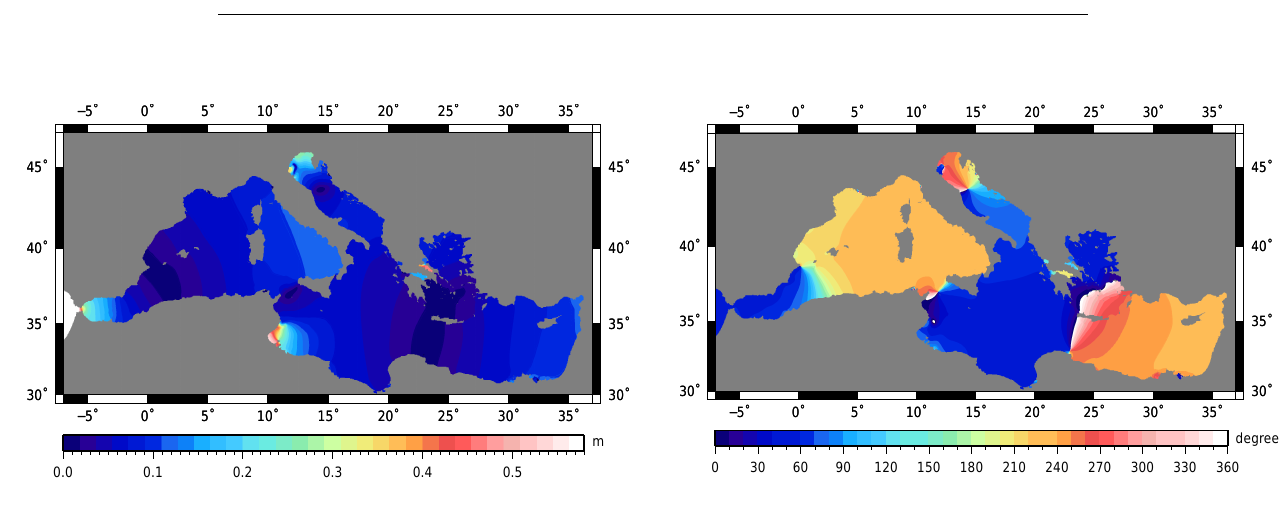
Fig.4. AmplitudeoftheM2constituent Fig. 4. Amplitude of the M2 constituent. the control data-set (ii). Taking into account that these data are included in our final solution MEDI10, the results of Ta- ble 12 could not be used in ranking MEDI10, with respect to TPXO7.2 and MED2008.